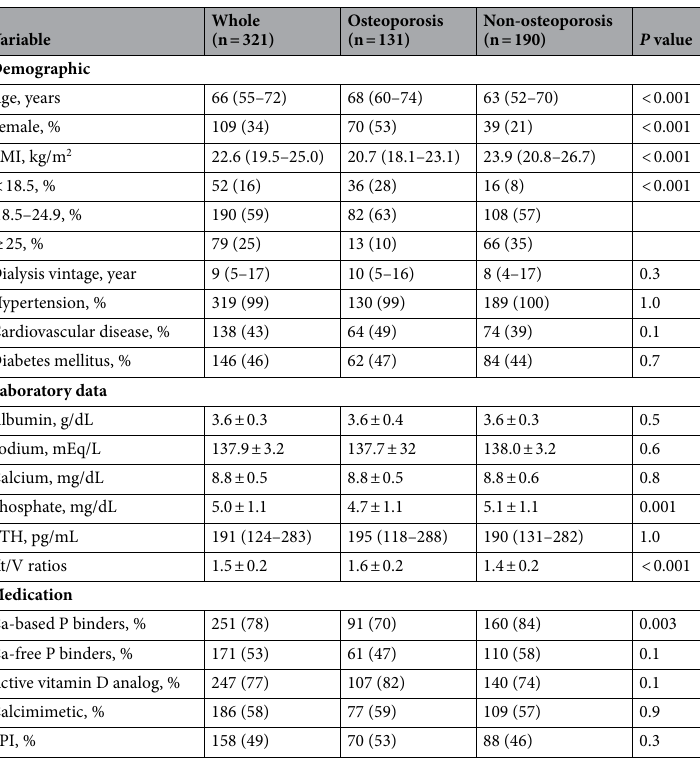
Table 1. Characteristics of the study participants. Data are shown as numbers (percentiles) for categorical variables and mean ± SD or median (interquartile range) for continuous variables. P < 0.05 was considered significant. BMI, body mass index; Ca, calcium; P, phosphate; PPI, proton pump inhibitor; PTH, parathyroid